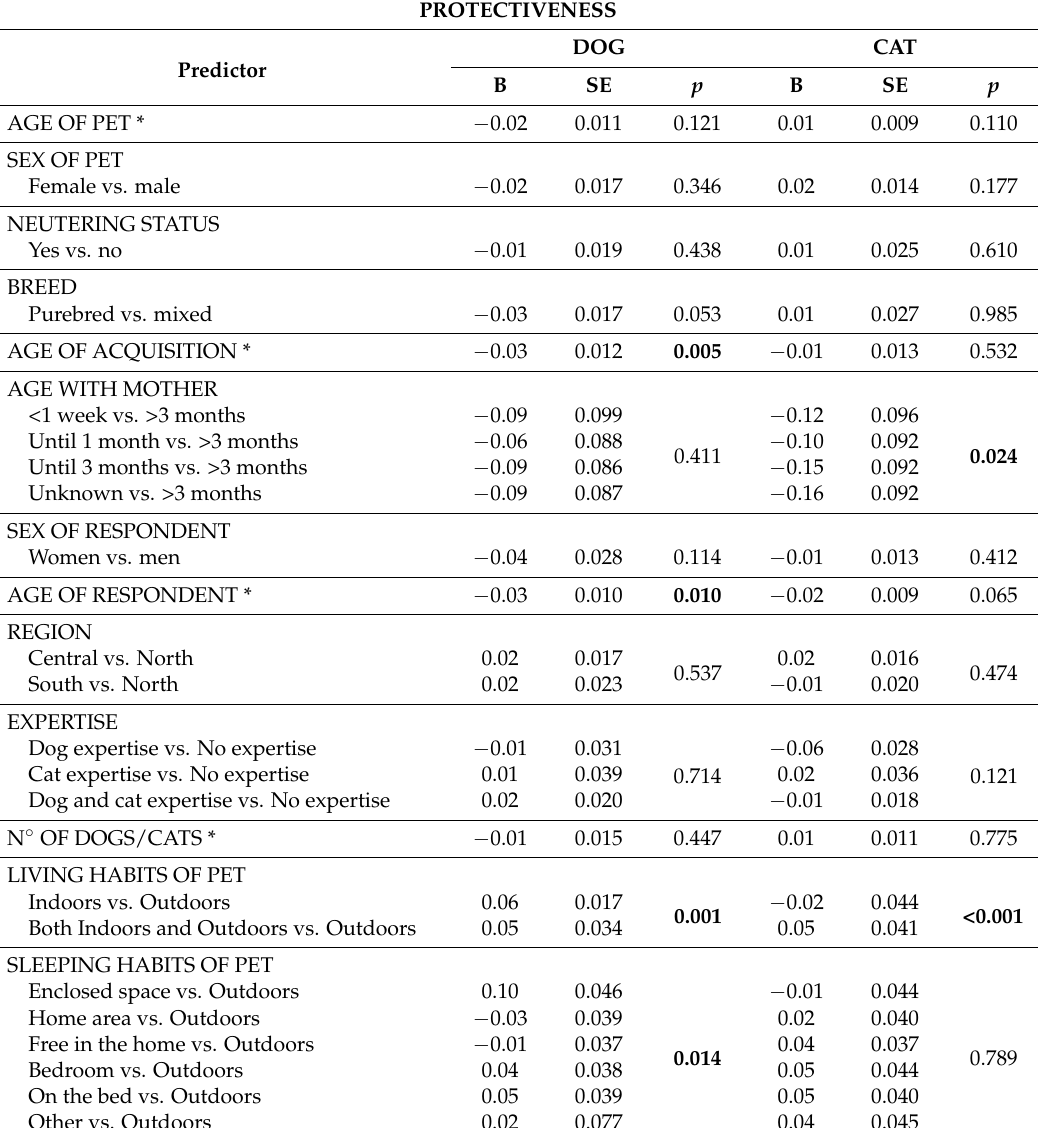
Table 3. Multivariate regression analysis for protectiveness in dogs and cats living in the same